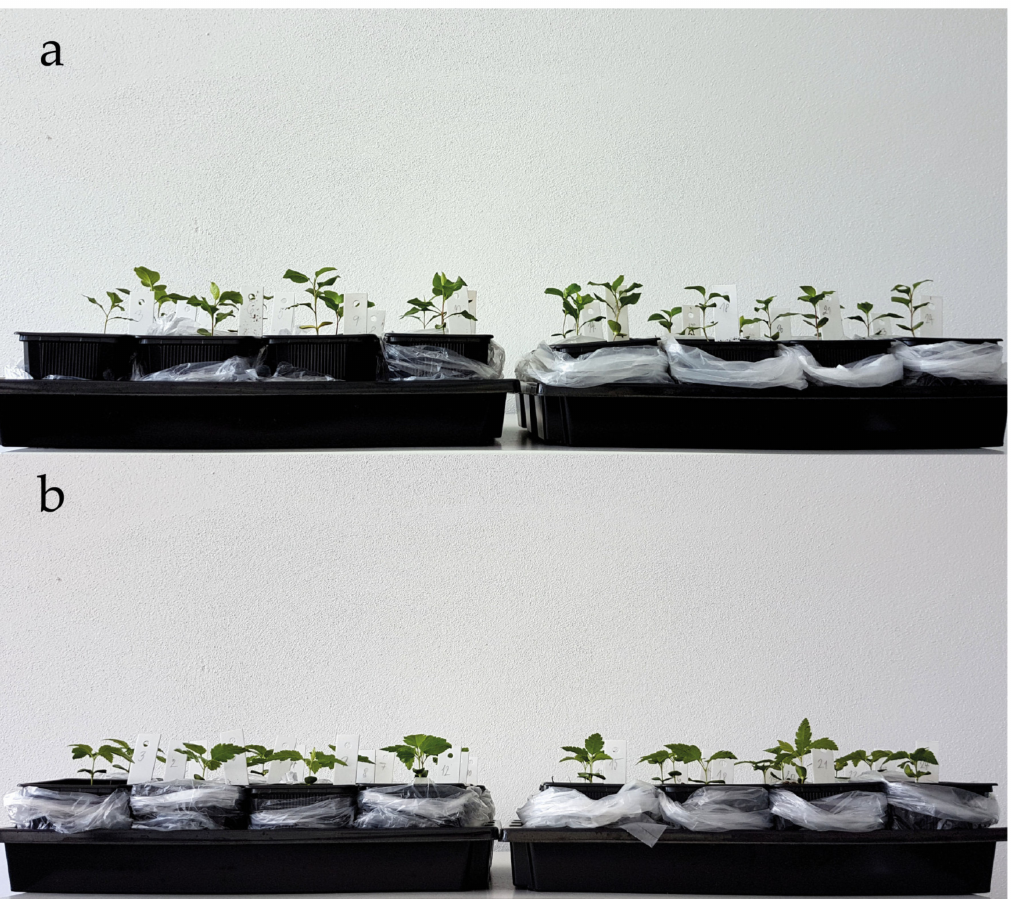
Figure 1. The seedlings of ( a ) P. pyraster and ( b ) S. torminalis after acclimatization in the beginning of experiment with di ff erent water regime; ( left ) control plants; ( right ) plants grown under drought